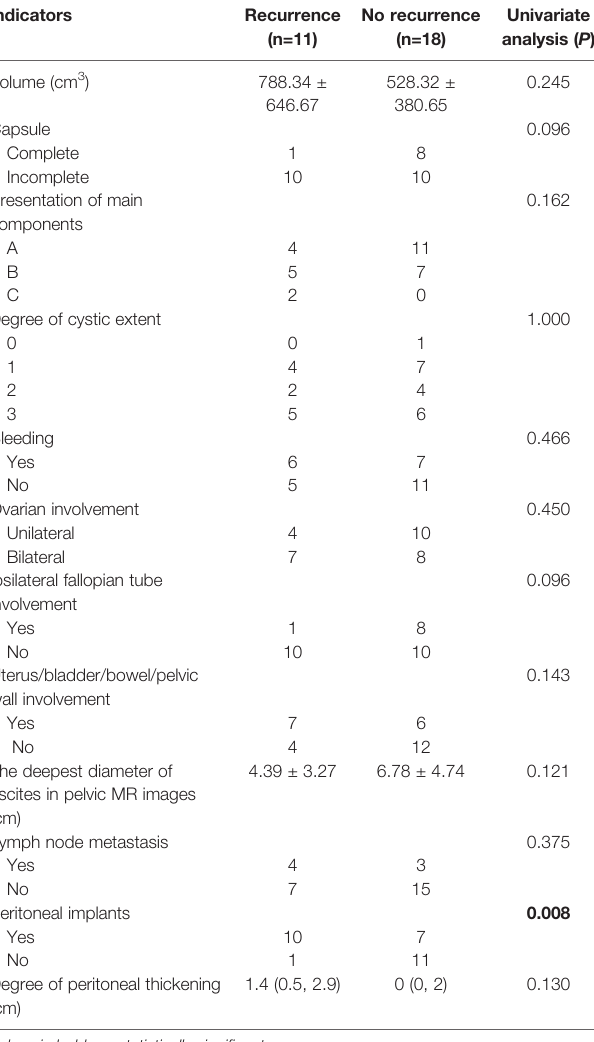
TABLE 3 | The statistical results of univariate analysis of the main CT and MRI features of the recurrence and no recurrence groups. Indicators